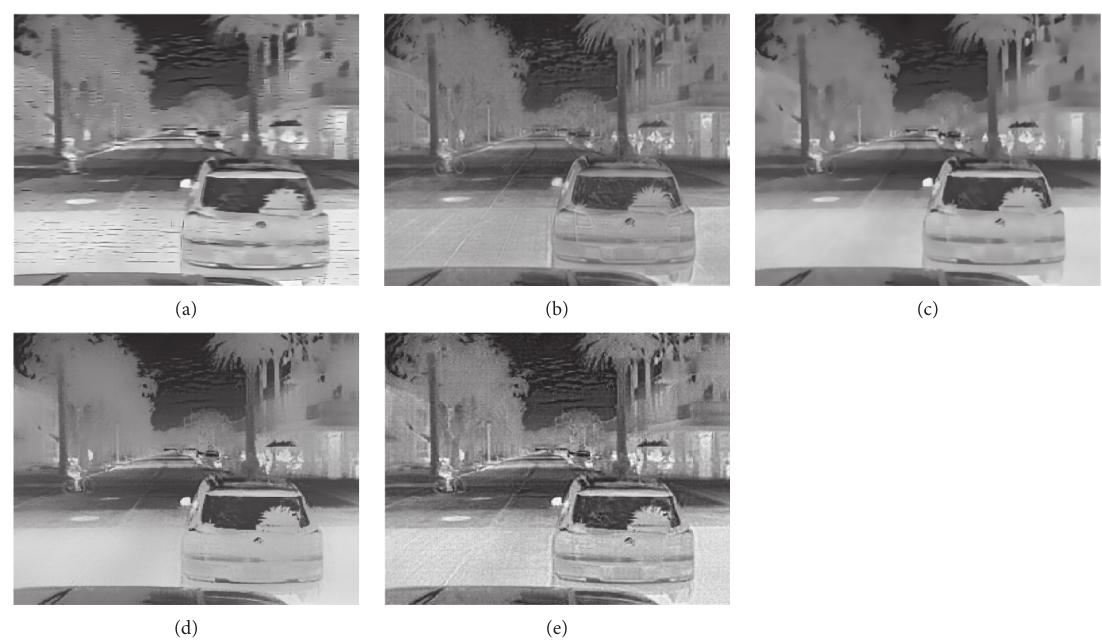
Figure 9: Effect picture of the ablation experiment. (a) Remove the dark channel prior loss function. (b) Remove the bright channel prior loss function. (c) Replace perceptual loss with L1 loss. (d) Replace perceptual loss with L2 loss. (e) Ours.